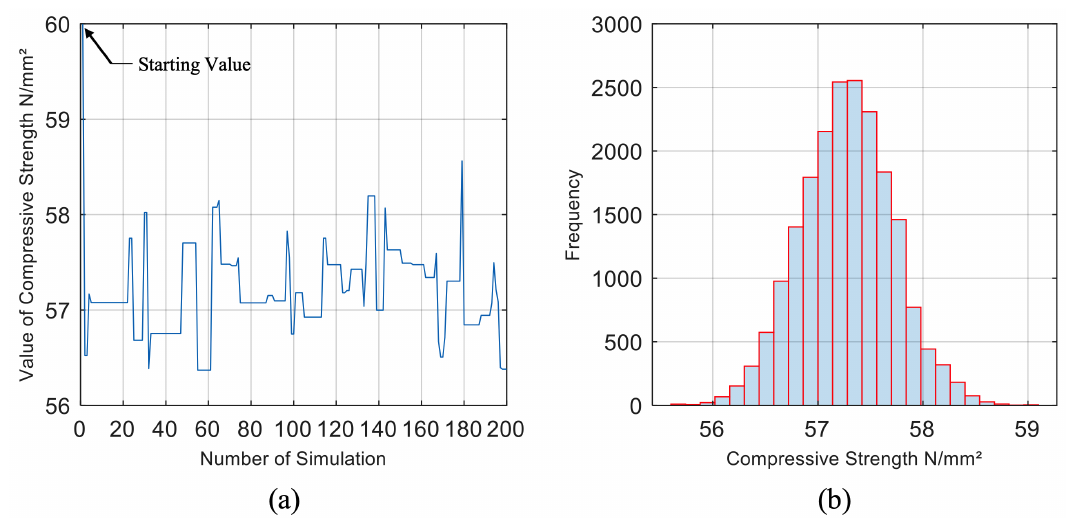
Figure 5. (a) Traceplot of the first 200 samples for a simulation using 5 measurements (No. 1,3,4,7,12); (b) Histogram of the samples from the posterior distribution using 5 measurements (No.